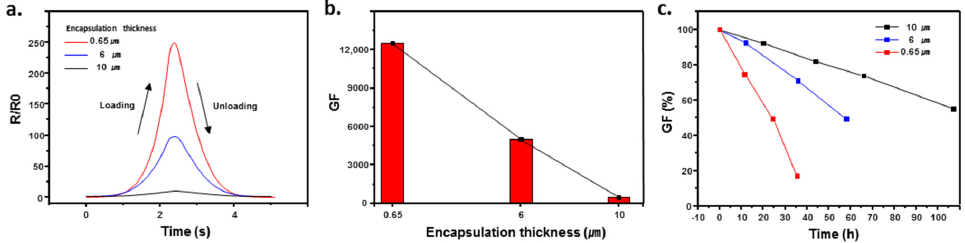
Figure 3. Comparison of performance changes according to PI encapsulation thickness. ( a ) Resistance response in two ‐ percent strain for various encapsulation thicknesses. ( b ) Gauge factor comparison by encapsulation thickness. ( c ) Performance comparison by encapsulation thickness in saline solution (0.9%